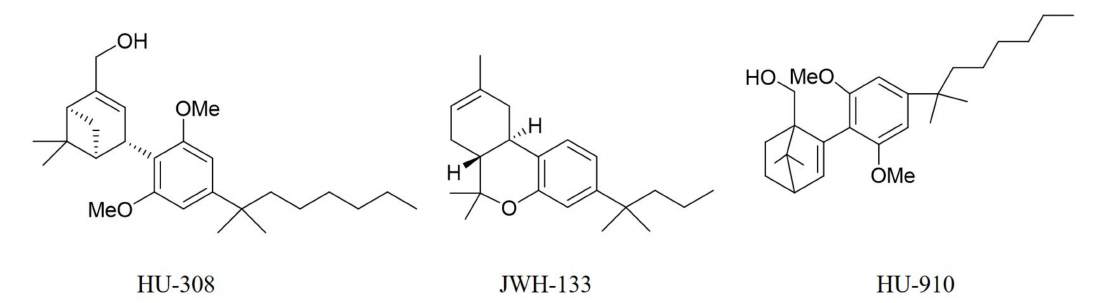
Figure 1. Chemical structure of some CB2 receptor agonists.